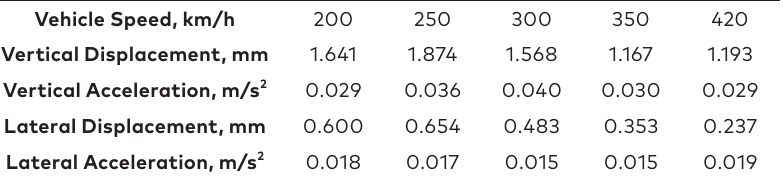
Table 8. Peak dynamic response of